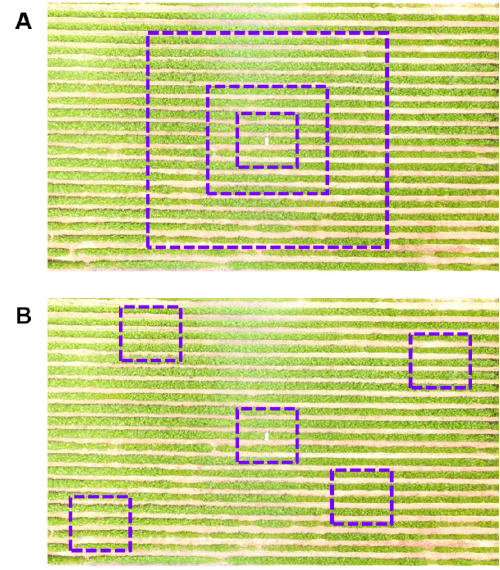
Figure 5. Sampling approaches for generating point cloud data subsets used for estimating soybean height. Two approaches were taken. In the first approach (A), concentric subsets (from 2 to 32 m 2 ) were delineated around a point at which local ground truth measurements were recorded (indicated by a white board placed at ground level). In the second approach (B), 4 m squares were randomly placed to determine whether estimates derived from random samples throughout the field were representative of ground truth data.